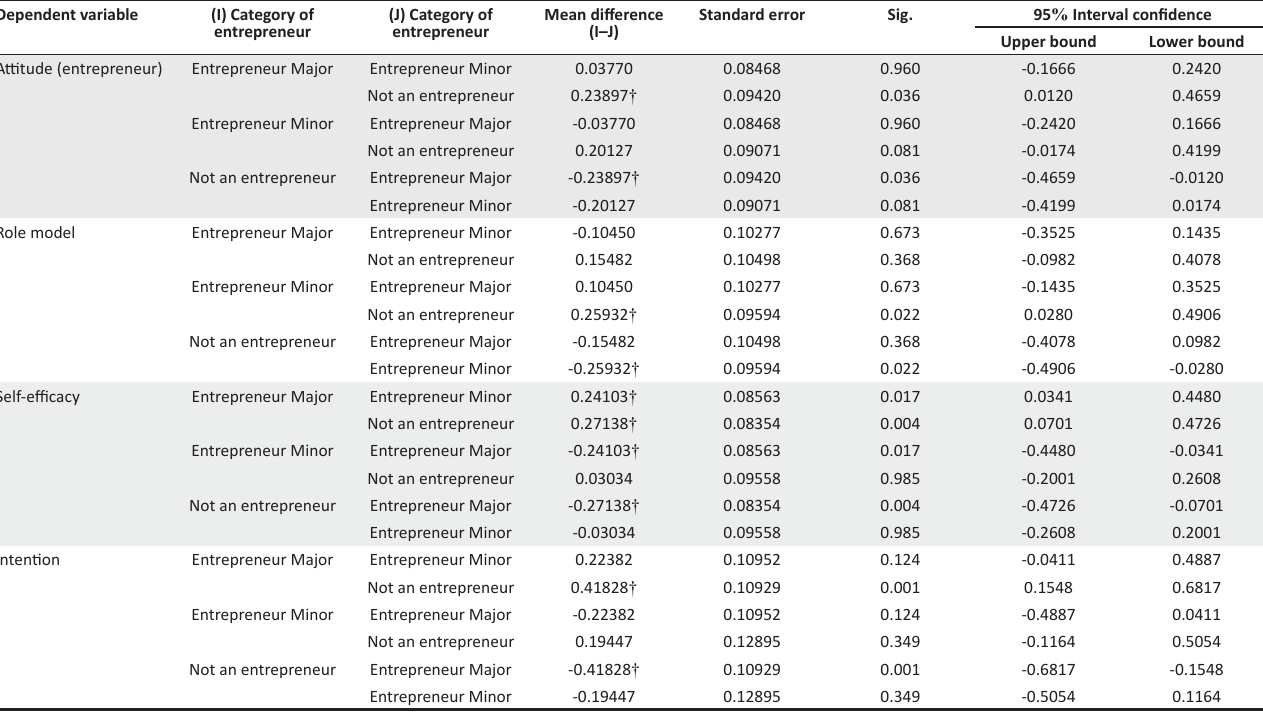
TABLE 9: Tamhane post hoc test for multiple comparisons. Dependent